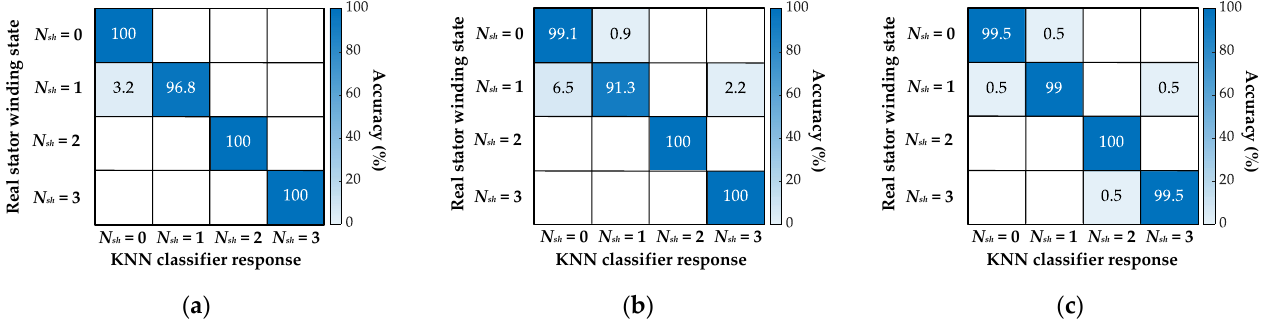
Figure 17. Confusion matrices for the on-line operation of the fault classifier: Test 1 ( a ), Test 2 ( b ) and Test 3 ( c ). Table 4. Details of the test scenarios.